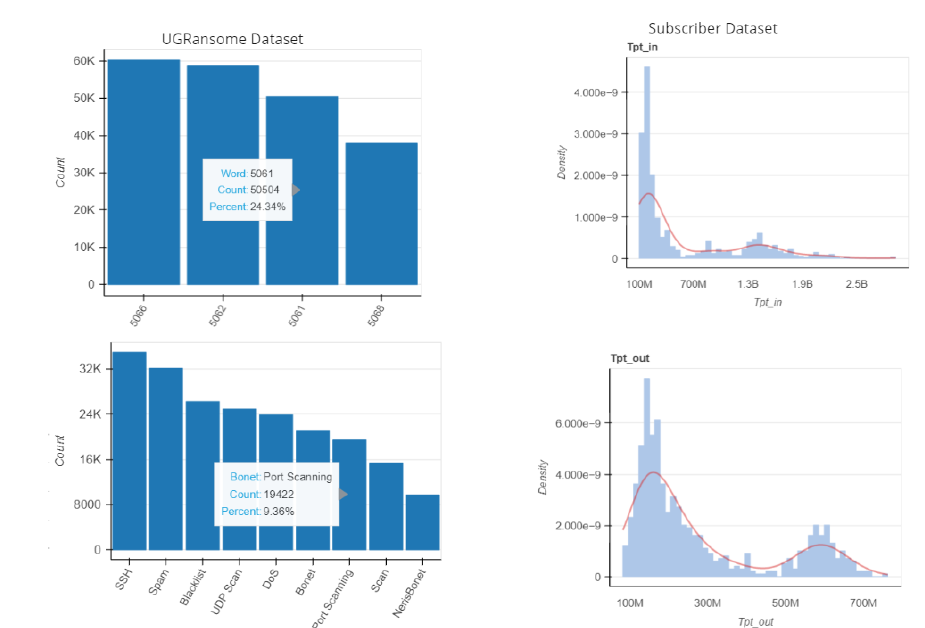
Figure 15. Additional features comparison.